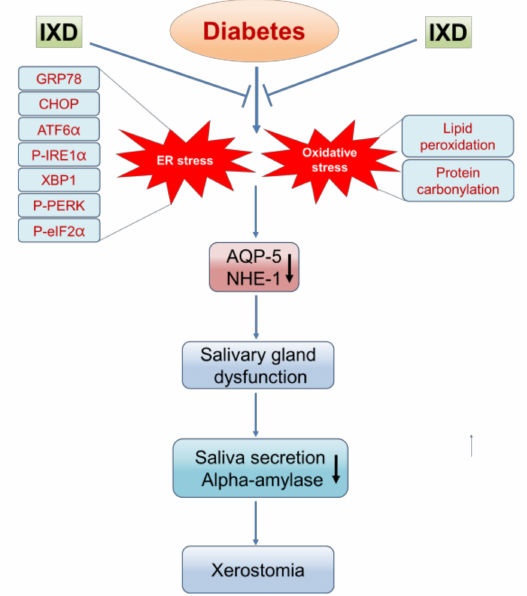
Figure 8. The proposed mechanism of an IXD extract against diabetes-induced